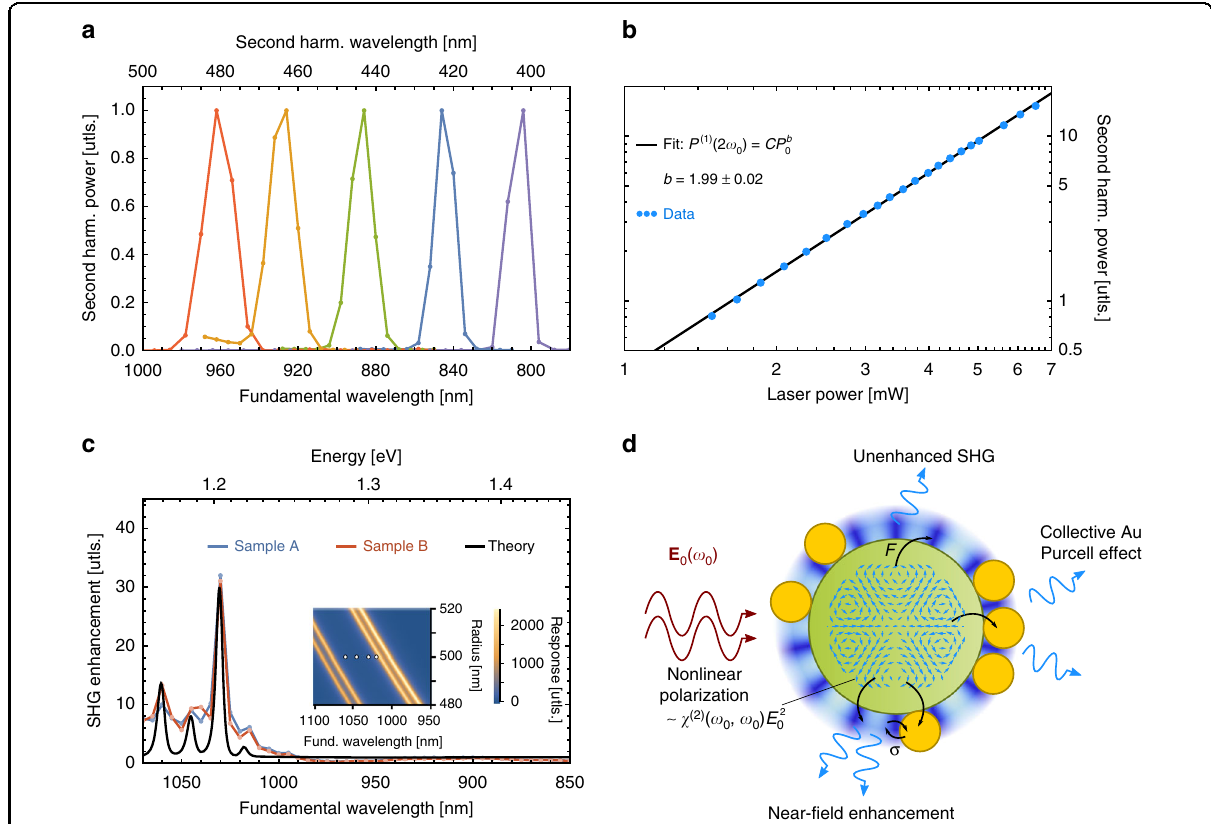
Fig. 4 Second harmonic generation enhancement. a SHG spectra of the Au – LiNbO 3 hybrid particles as the FW is tuned from 800 nm (violet) to 960 nm (red). b Power dependence of SHG at 800 nm. The power scattered at the SH (blue dots) is proportional to the input laser power at the FW to the power b = 1.99 (95% con fi dence interval of ±0.02, see fi t [black line]) times a normalization constant C . c Enhancement of the scattered SHG power as a function of the fundamental wavelength for an individual hybrid Au – LiNbO 3 nanostructure recorded by sweeping the excitation laser wavelength from 850 to 1070 nm with a step size of 5 nm. The experimental results (blue, red) are overlaid by the modeled near- fi eld coupling enhancements (black). The plotted curves are shifted phenomenologically by 10 – 25 nm from the solutions of Eq. (1) to align with the experiment, as is highlighted in the “ Discussion ” . Inset: response functions (SI, Section S.2.4.2) of the narrow Mie resonances of a bare LiNbO 3 sphere as a function of the sphere radius and photon energy. The response function maxima (gold/white) lie at the same resonance energies ω β as the SHG enhancement peaks, implying a red (blue) shift in the narrow SHG enhancement features with increasing (decreasing) a 2 . The white dots indicate the shifted peak positions shown in the main panel. Further details are available in the SI. d A diagram of the pathways for energy transfer of light within the system. Clockwise from left: incident light (dark red), SHG (blue arrows) through energy transfer from nonlinear polarization (blue vector fi eld) to Mie resonances (halo), superradiant Purcell-enhanced SHG, and near- fi eld enhanced